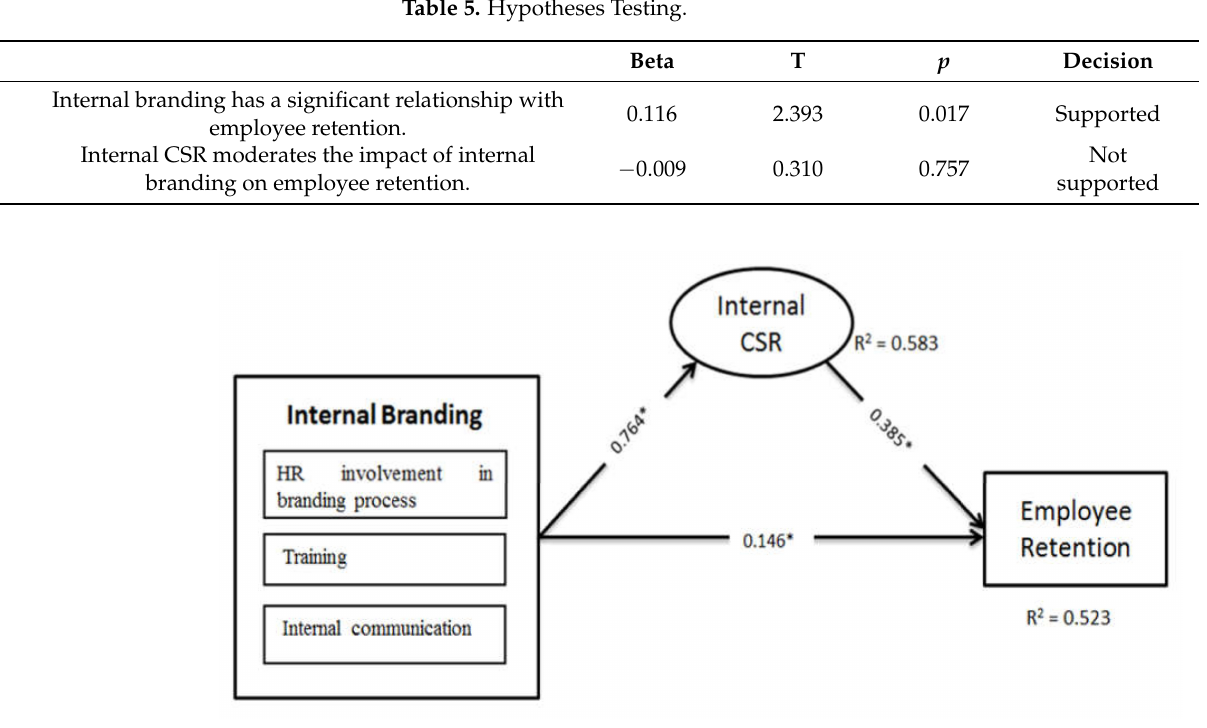
Figure 2. Results portrayal through the conceptual model. *: level of significance is 0.05.